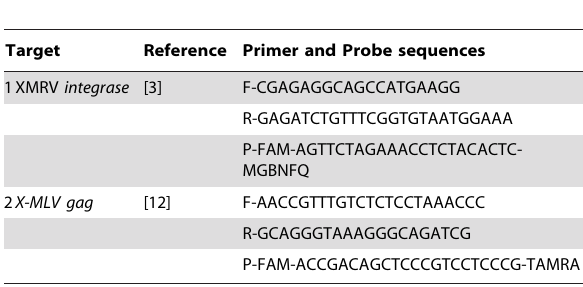
Table 1. Sequences of TaqMan PCR primer/probe sets used to screen HIV-1-positive patient leukocyte